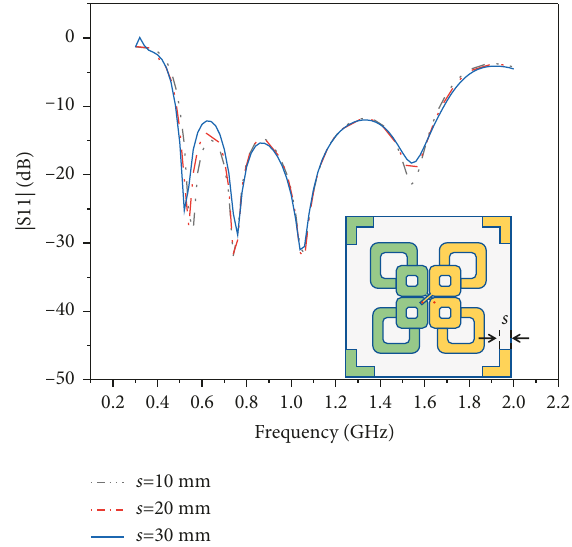
Figure 7: Effect of the width (s) of the parasitic patch on S11.